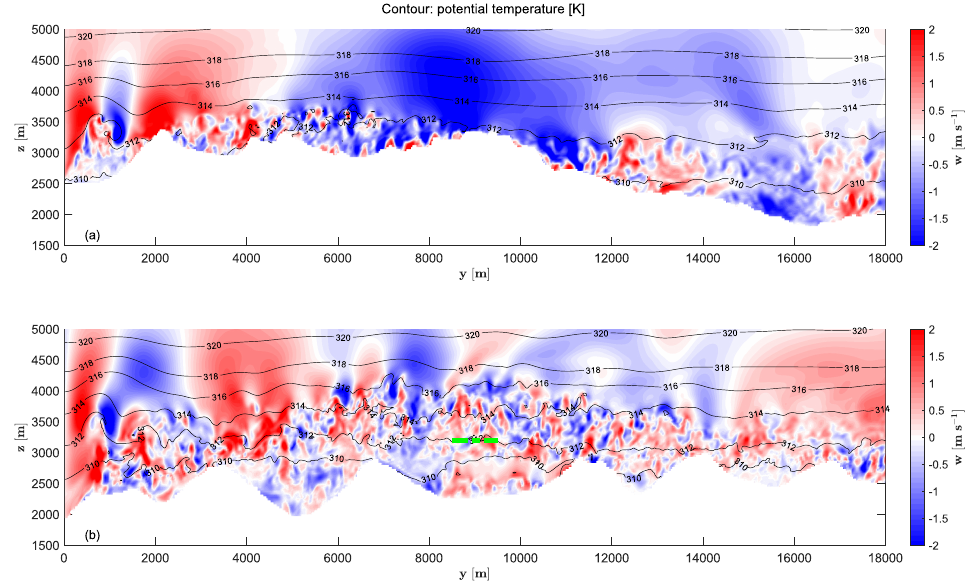
Figure 14. Instantaneous y-z cross-sections of vertical wind speed w and potential temperature θ (contours) at 10,800 s after the start of the simulation at 06:00 UTC, taken at ( a ) x = 8704 m (position 1) and ( b ) x = 23,840 m (position 2) in the local simulation coordinate. The green dashed line in ( b ) indicated the position of x-y cross sections shown in Figure 15.